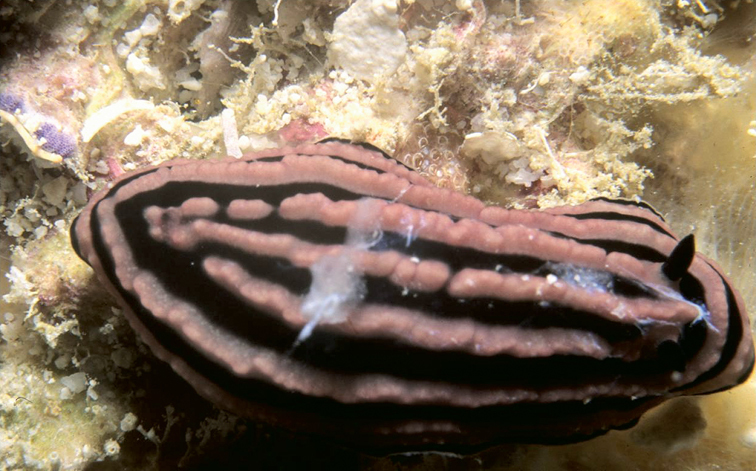
Phyllidiella rosans, 30 mm, Maldives, photo: N Yonow (note defensive exudates).